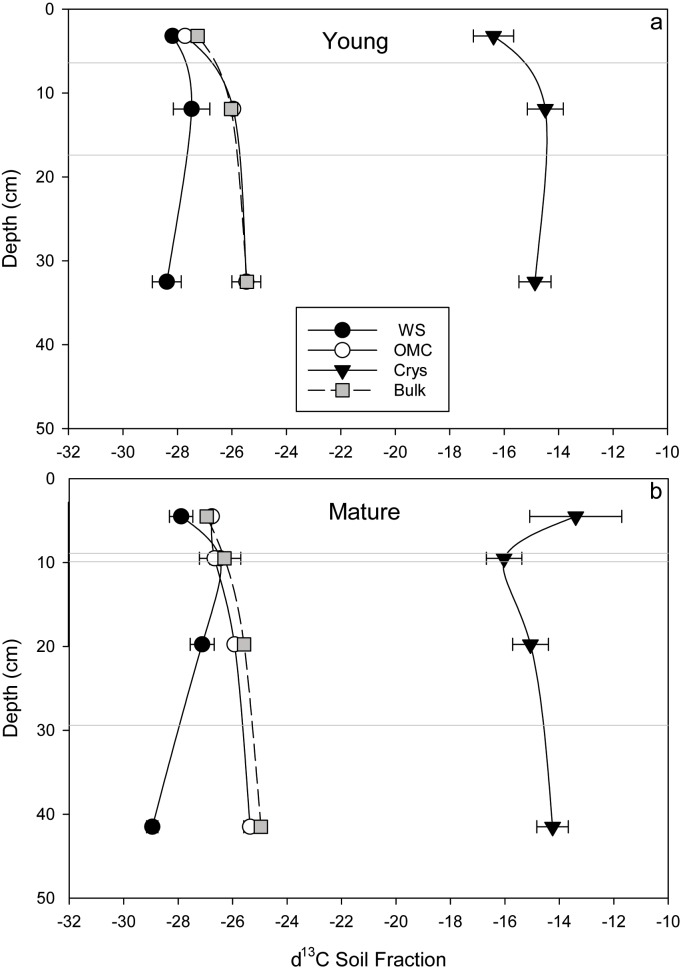
(a and b) Results of stable isotopic analysis of carbon (δ13C) in genetic horizons through depth at Young and Mature forest sites sequential selective dissolutions for water soluble, organo-mineral, and crystalline fractions. Grey lines indicate the position of Ae, Bh, Bf and BC horizons in sequence through depth for the Young and Mature sites. δ13C bulk soil at both sites (white circles) are included for comparison. Note how closely the bulk soil δ13C follows the trajectory of that of the organo-mineral fraction.